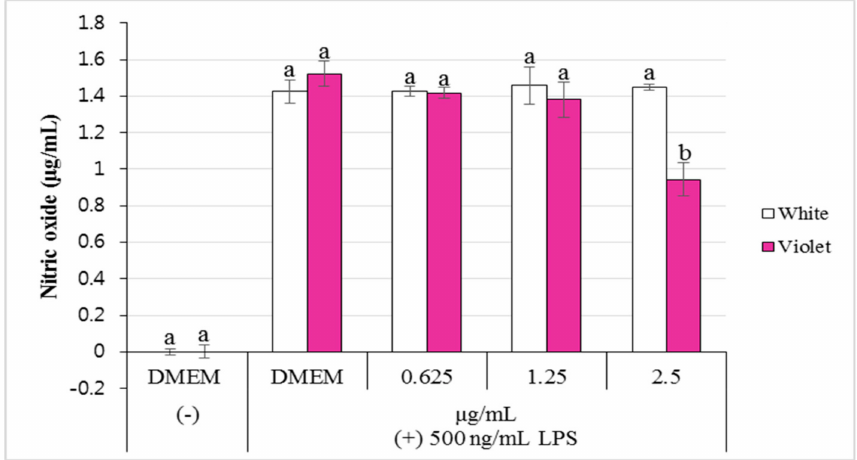
Figure 5. Effect of ethanol extracts from white and violet flowers, respectively, on NO production in LPS-activated RAW264.7 cells. Cells were treated extracts of various concentrations (0.625 to 2.5 µ g/mL). The amount of NO in the culture medium was measured using a NO assay. Shown are the mean values (in per cent) of triplicated experiments ± SD. Different letters (a, b) indicate a significant difference at p < 0.05, applying a Duncan’s Multiple Range Test